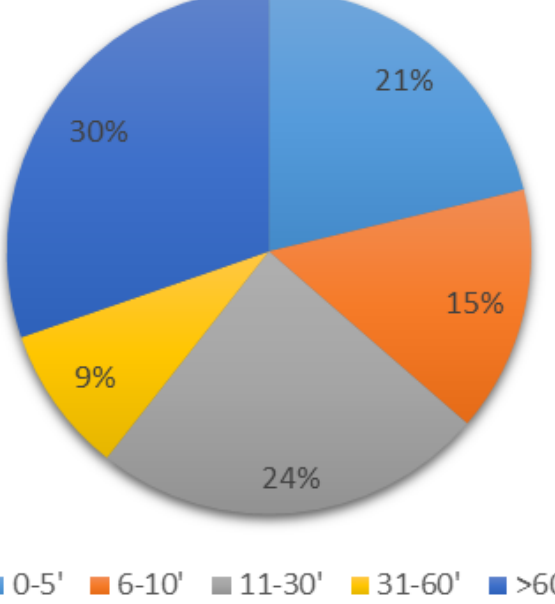
Figure 3. Time of the first samples relative to time of clinical symptoms (min, n = 33).